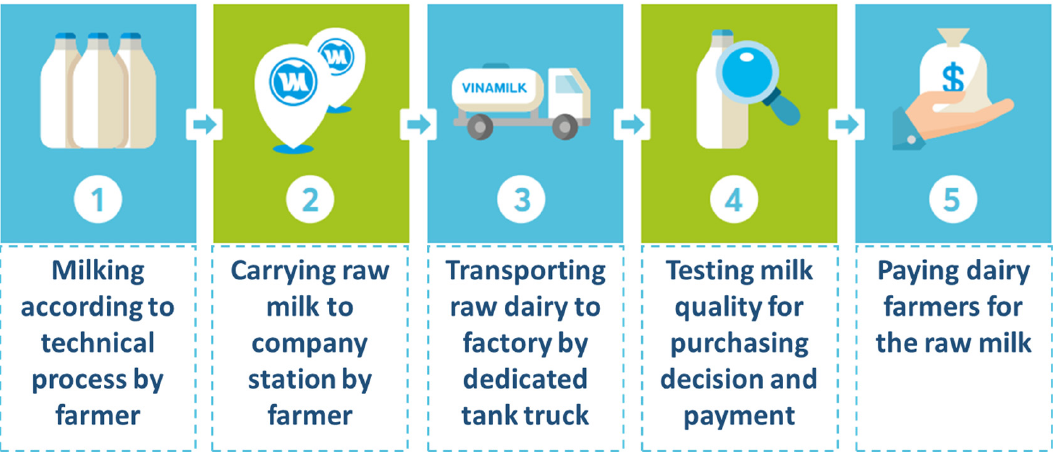
Figure 8. The process of purchasing, transporting, testing, and payment of the Vinamilk company. Reprinted from Vinamilk [64].